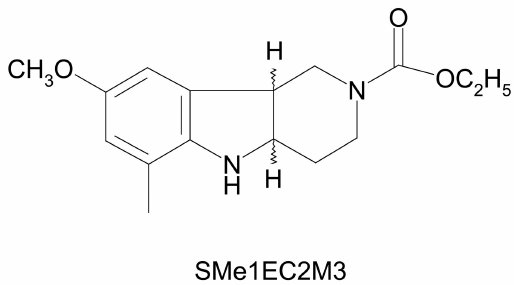
Figure1. Structuralformulaof(( ± )- cis ethyl8-methoxy-6-methyl-3,4,4a,5,9b H -hexahydro-1 H -pyrido[4,3-b] indole-2-carboxylate